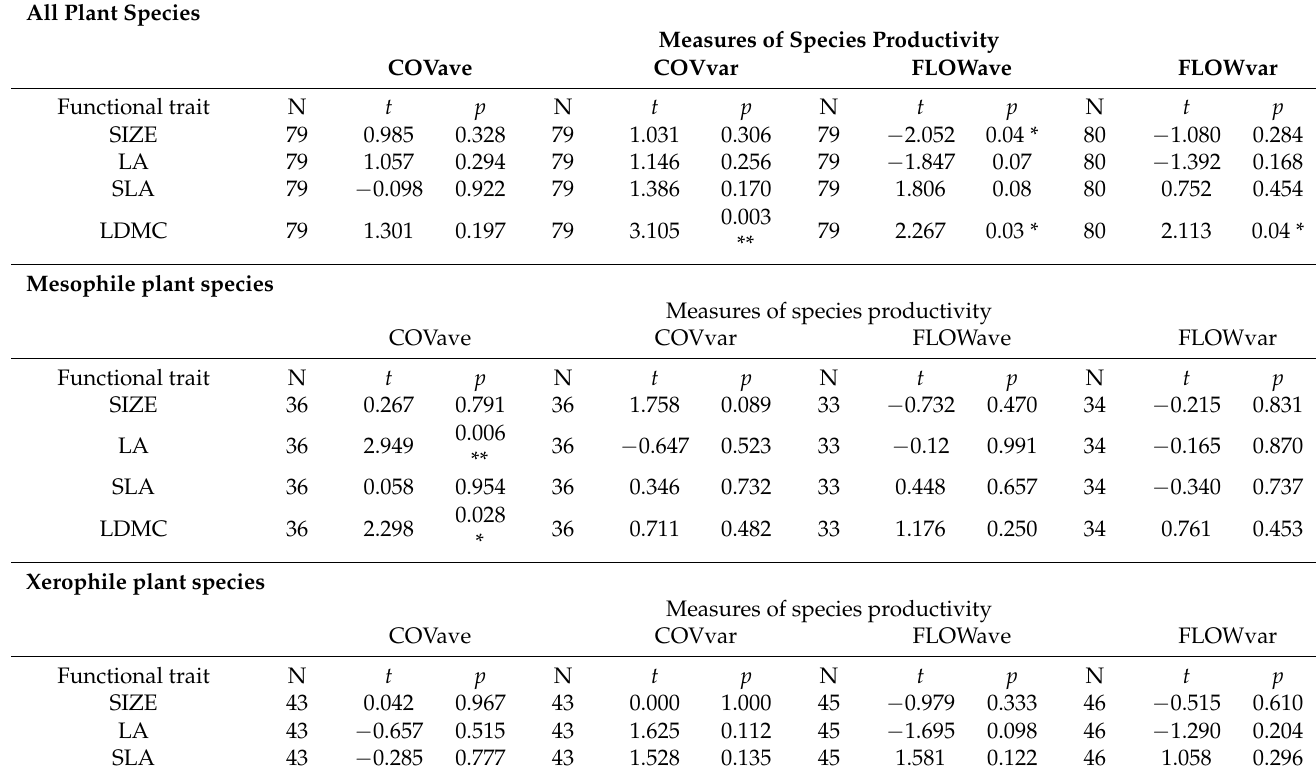
Table 2. Coefficients produced by the regression models carried out on log-transformed data of each measure of plant productivity (dependent variable) against the species functional traits (independent variables); separate models were ran by considering the whole species target and by distinguishing the species from different community type. ** coefficient significant at the 0.01 level; * coefficient significant at the 0.05 level. Abbreviations: COVave = average values of cover; FLOWave = average values of flowering; COVvar = variance of cover; FLOWvar = variance of